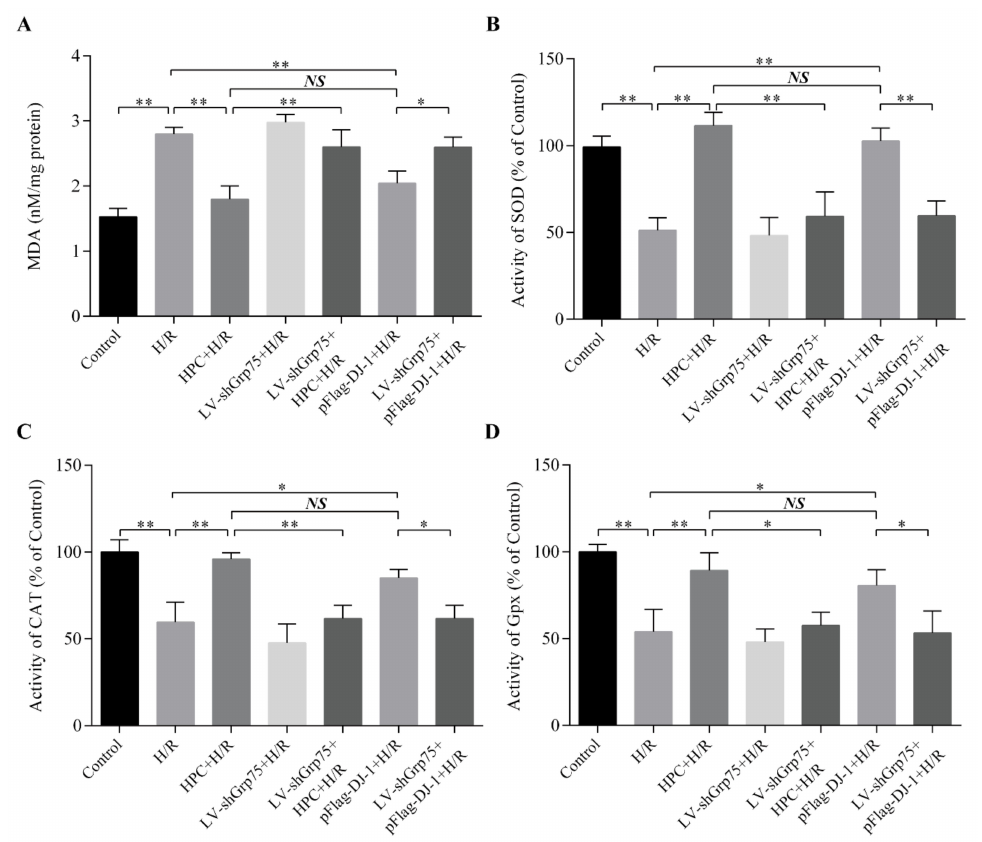
Figure 7. E ff ects of Grp75 knockdown on DJ-1-mediated inhibition of oxidative stress by hypoxic preconditioning (HPC) in H9c2 cells undergoing hypoxia / reoxygenation (H / R). H9c2 cells were infected by lentiviral (LV) vectors LV-shGrp75 for 72 h and then subjected to HPC 24 h prior to H / R or transfected with pFlag-DJ-1 for 48 h followed by H / R. Subsequently, oxidative stress was monitored by measuring the MDA content ( A ) and total activities of antioxidant enzyme superoxide dismutase (SOD) ( B ), catalase (CAT) ( C ), and glutathione peroxidase (GPx) ( D ), as described in the Materials and Methods section. Each value represents the mean ± SD of three independent experiments. * p < 0.05, ** p < 0.01 as indicated on the figure. NS indicates no